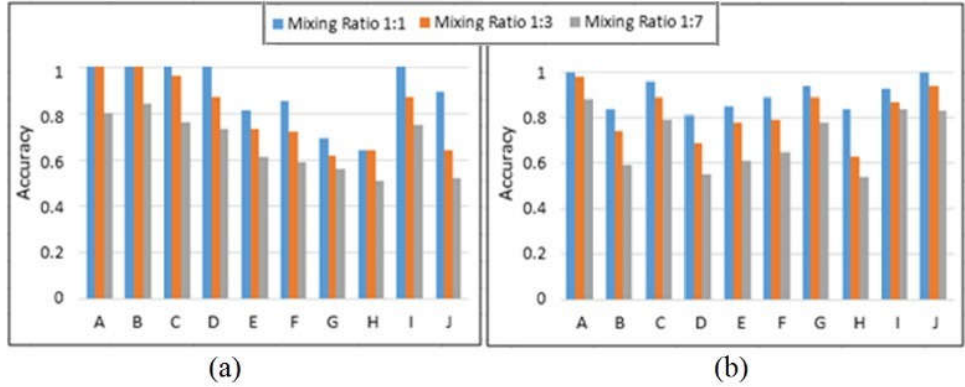
Figure 8. FCM and feature selection obtained segmentation accuracy on ( a ) black ink combinations and ( b ) blue ink combinations with varying mixing ratios.